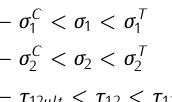
Fig.7. Finite element model of 8A and 8B impellers Figure 7. Finite element model of 8A and 8B impellers.